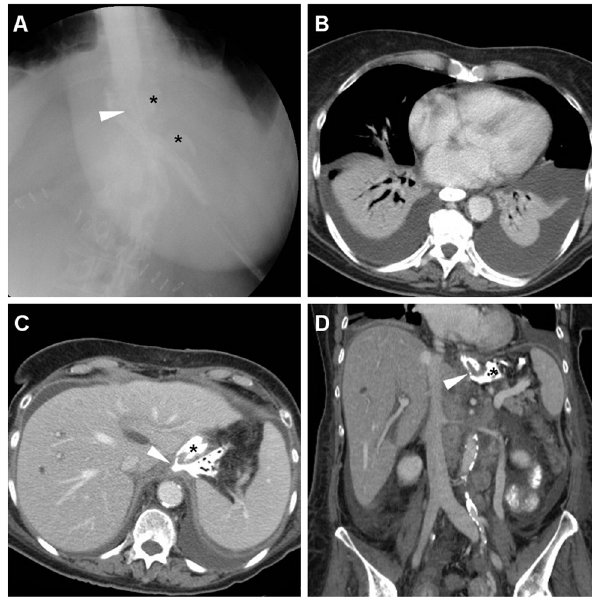
Fig. 8 In a 69-year-old woman with advanced carcinoma of the gastric body, palliative total gastrectomy was performed. Five days after surgery, CF (A) showed patent EJS with opacification of extensive anastomotic leakage (*). A few days later, on conservative management, contrast- enhanced CT (B-D) showed bilateral pleural effusions and atelectasis (B), patent EJS (arrowheads) and persistent leak (*)